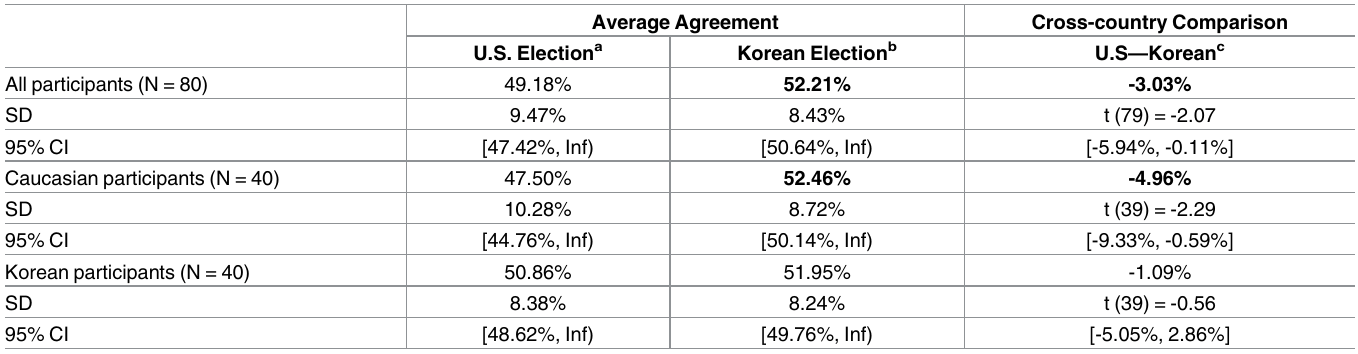
Table 5. Associations between real election outcomes and face-based inferences of